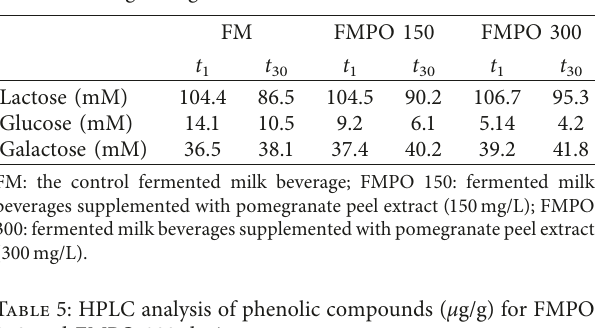
Table 4: Concentrations (mM) of sugars of FMPO 150, FMPO 300, and FM during storage.